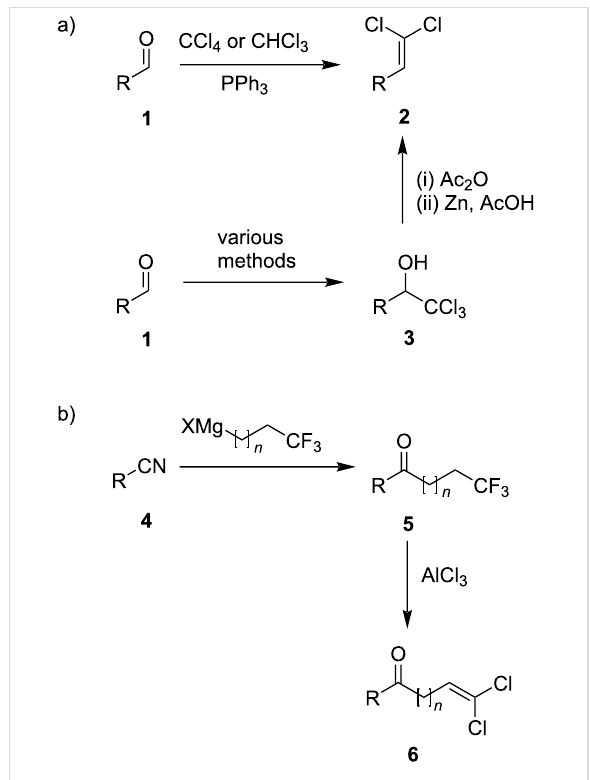
Figure 2: a) Common methods for the preparation of 1,1-dichloro-1- alkenes from aldehydes. b) This work: a two-step synthesis of 1,1- dichloro-1-alkenones from nitriles via